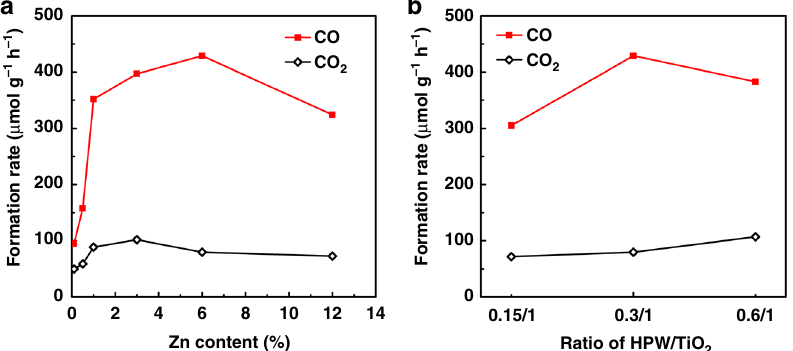
Fig. 2 Carbon monoxide and carbon dioxide production over Zn-HPW/TiO 2 catalysts. a In fl uence of different Zn loadings, b in fl uence of HPW/TiO 2